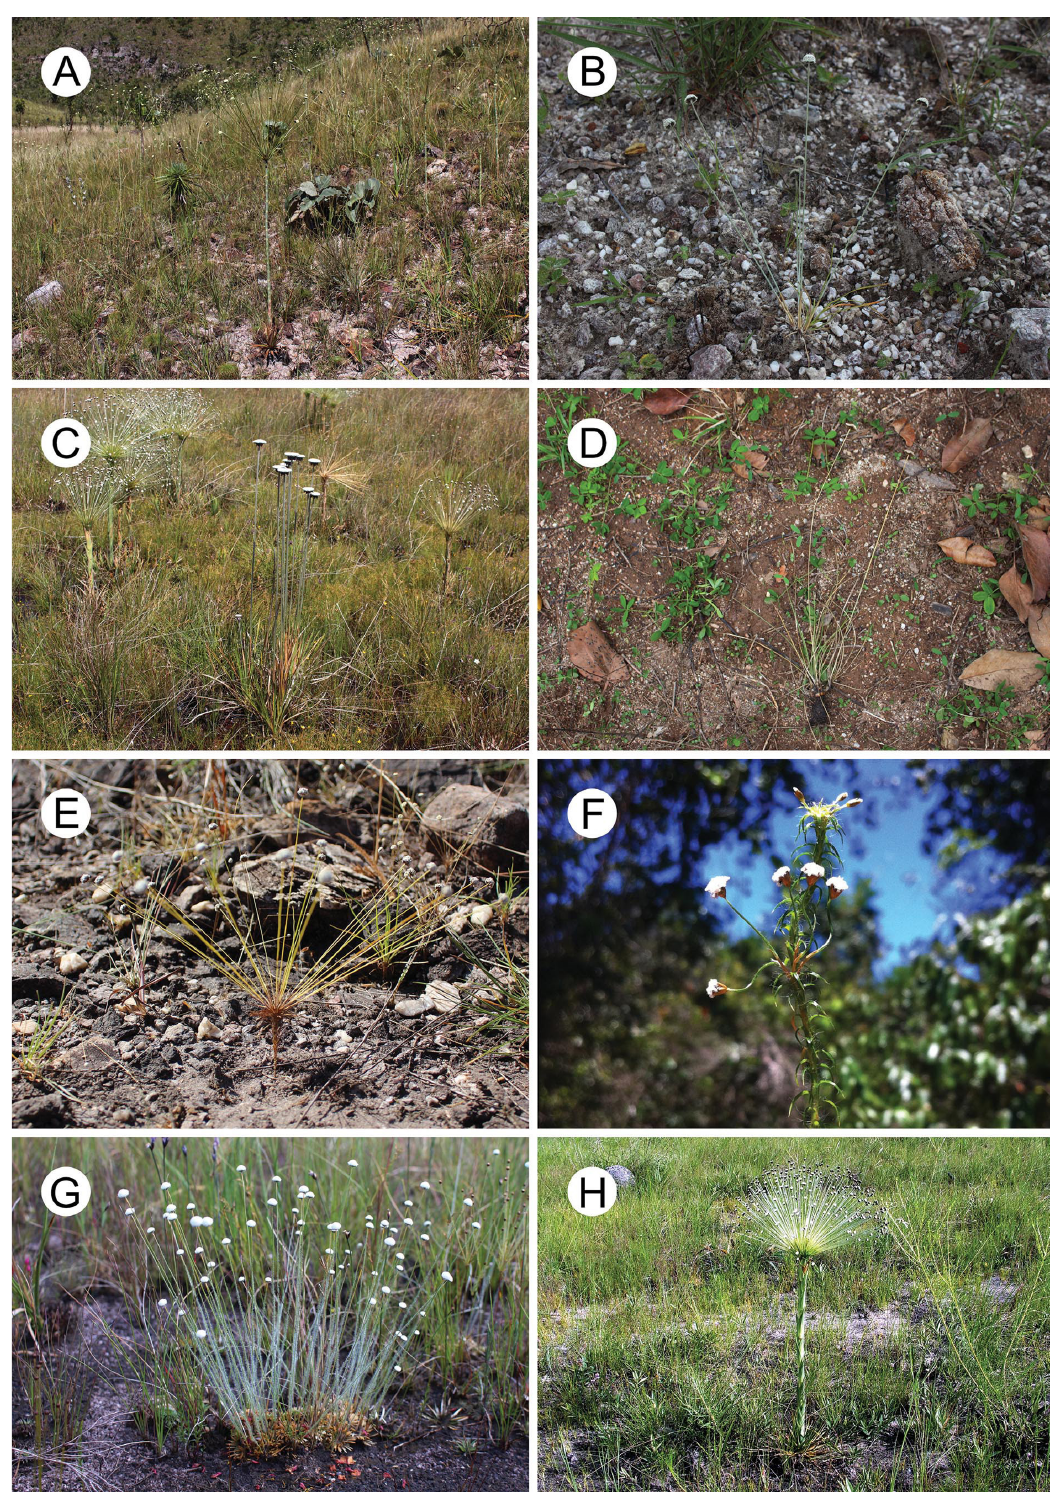
Fig. 8. Species of Paepalanthoideae (Eriocaulaceae) from the Chapada dos Veadeiros National